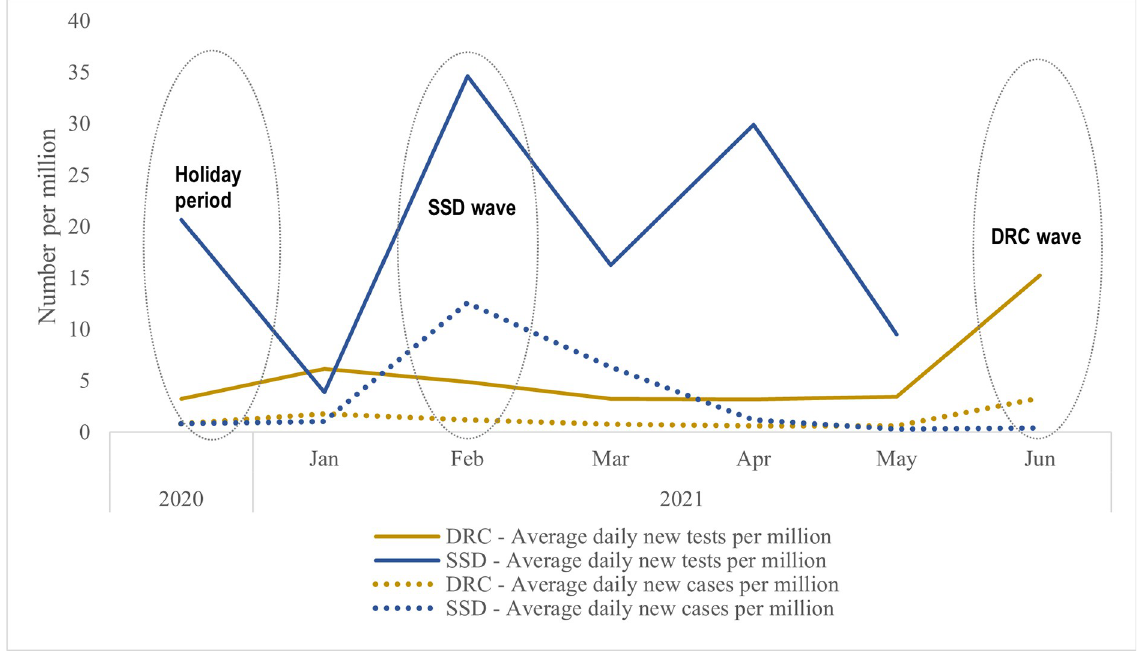
Fig 1. COVID-19 testing and case trends in the Democratic Republic of the Congo and South Sudan, December 2020-June 2021. SSD = South Sudan. The Democratic Republic of the Congo = DRC. Waves = Time periods with increases in infection. Holiday period = Time period from December to January. Source: Reproduced from data originally published by Hasell et al. in Nature [15].